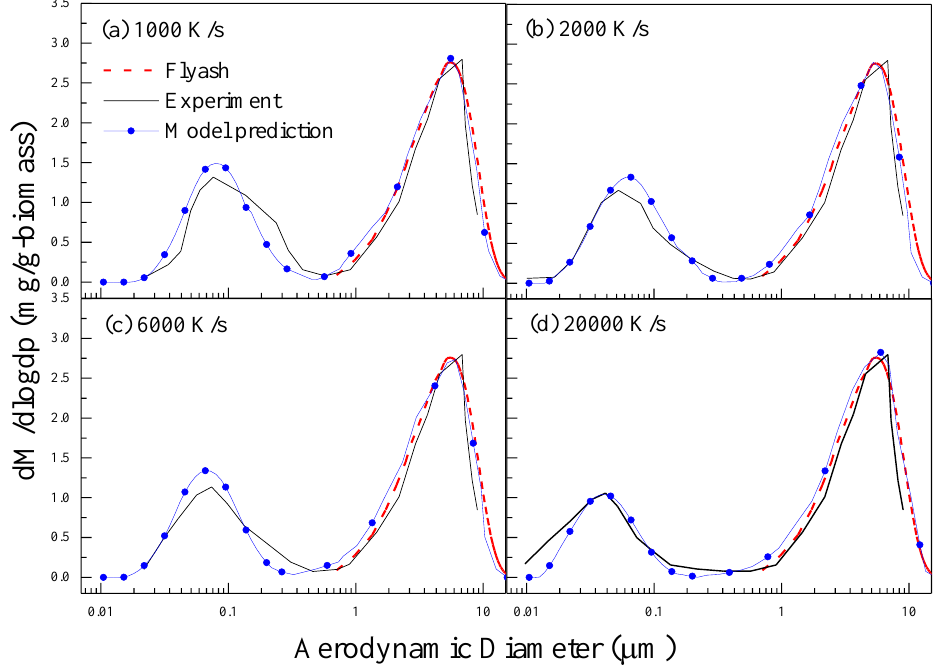
Figure 3. The calculated PSDs of PM 10 formed at four different cooling rates (1000, 2000, 6000, and 20,000 °C) at a biomass feeding rate of 0.25 g/min compared with the measurements [15]. The mass-based PSD of fine-mode particles calculated by the model and its variation with the cooling rate were also roughly consistent with the experimental results at the biomass feeding rate of 0.05 g/min (not shown here).